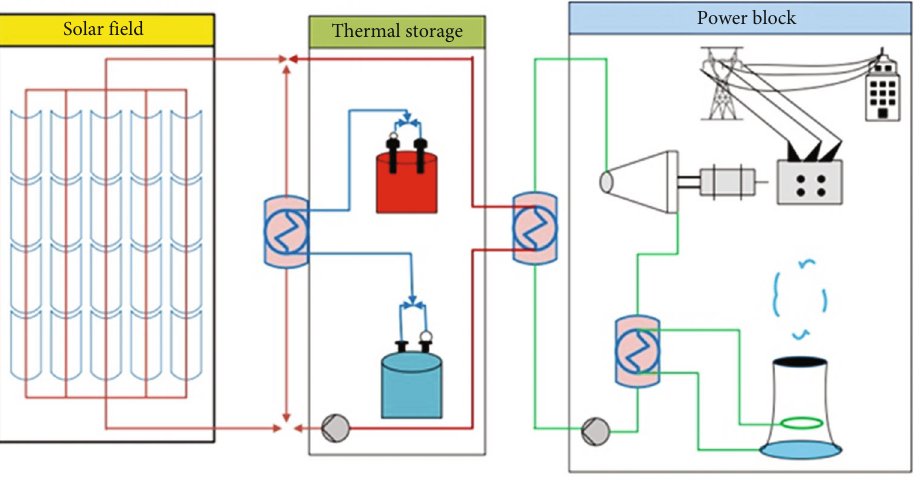
Figure 8: PT-CSP power plant model with TES.